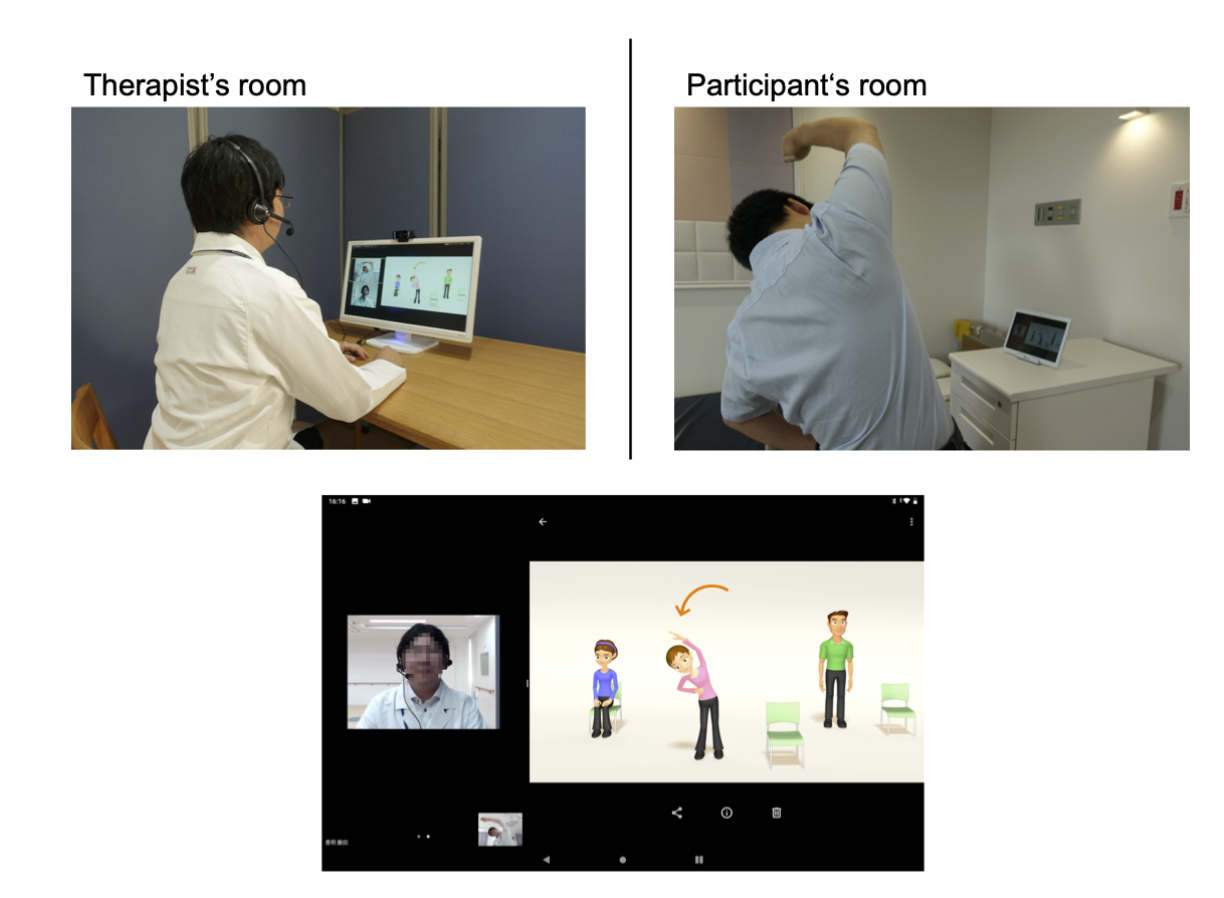
Figure 1. Exercise program delivered using the telerehabilitation system. Upper panel: A physical therapist instructs the patient about an